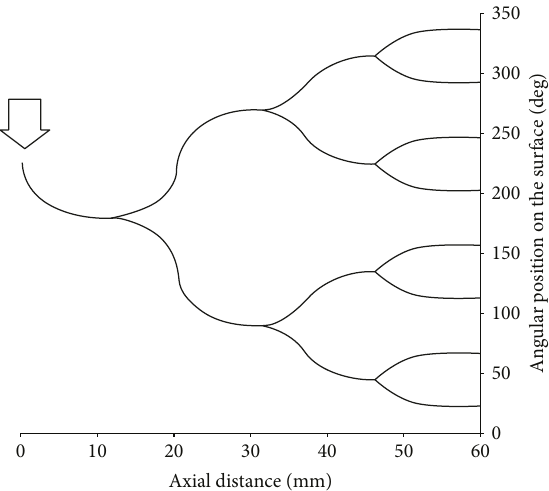
Figure 7: Trajectories of the fl ow in the grooves made on the surface of the middle cone. Shown here is the output from the milling machine control program. Milled grooves are made of 6mm diameter. It distributes the detonation wave into the 8 exits into the combustion chamber.